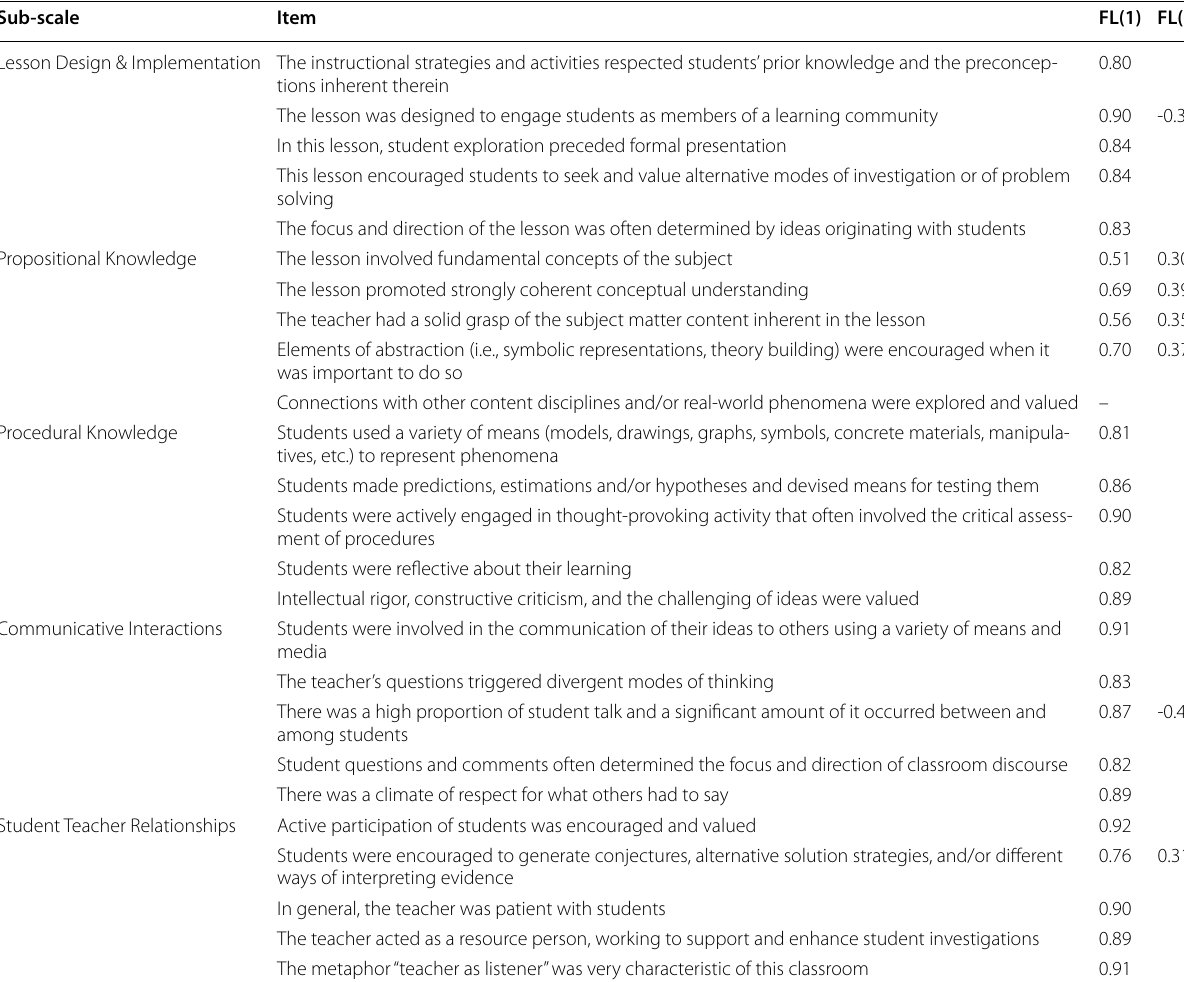
484) (factor loadings >|0.3| included) =